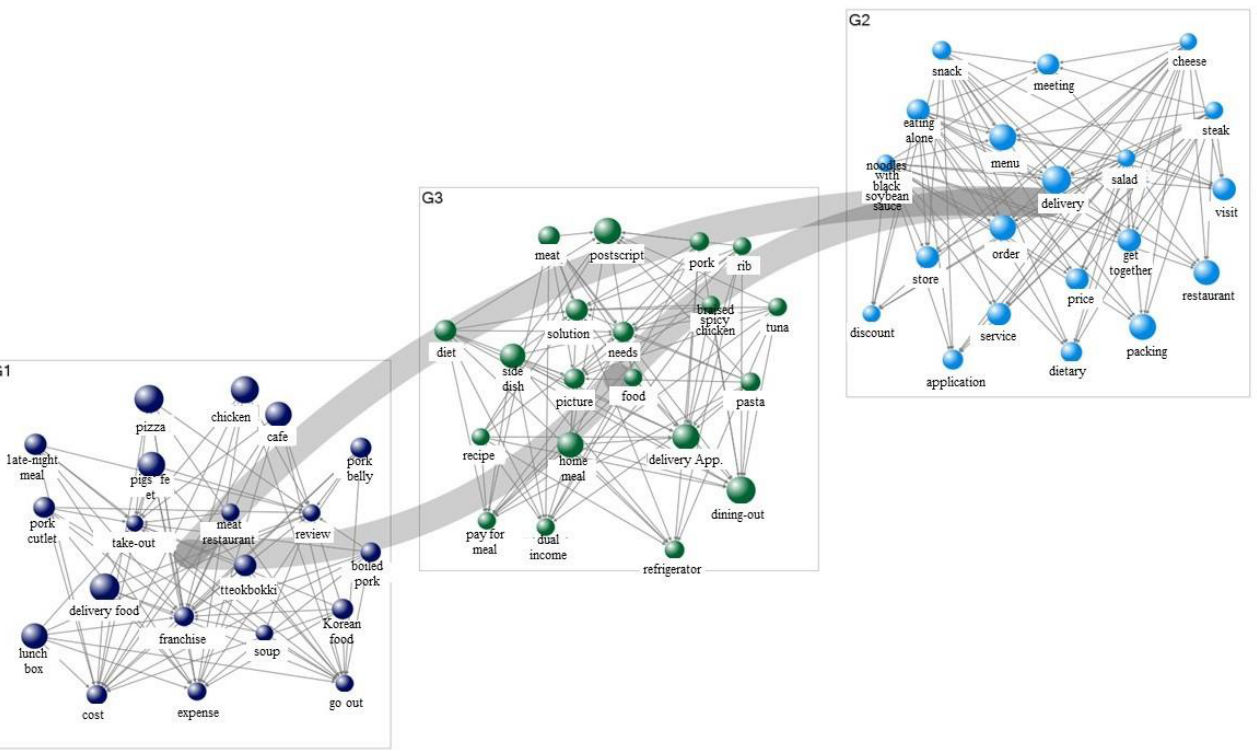
Figure 3. Demand network visualization of food delivery (2019). Table 8. Demand network index of food delivery